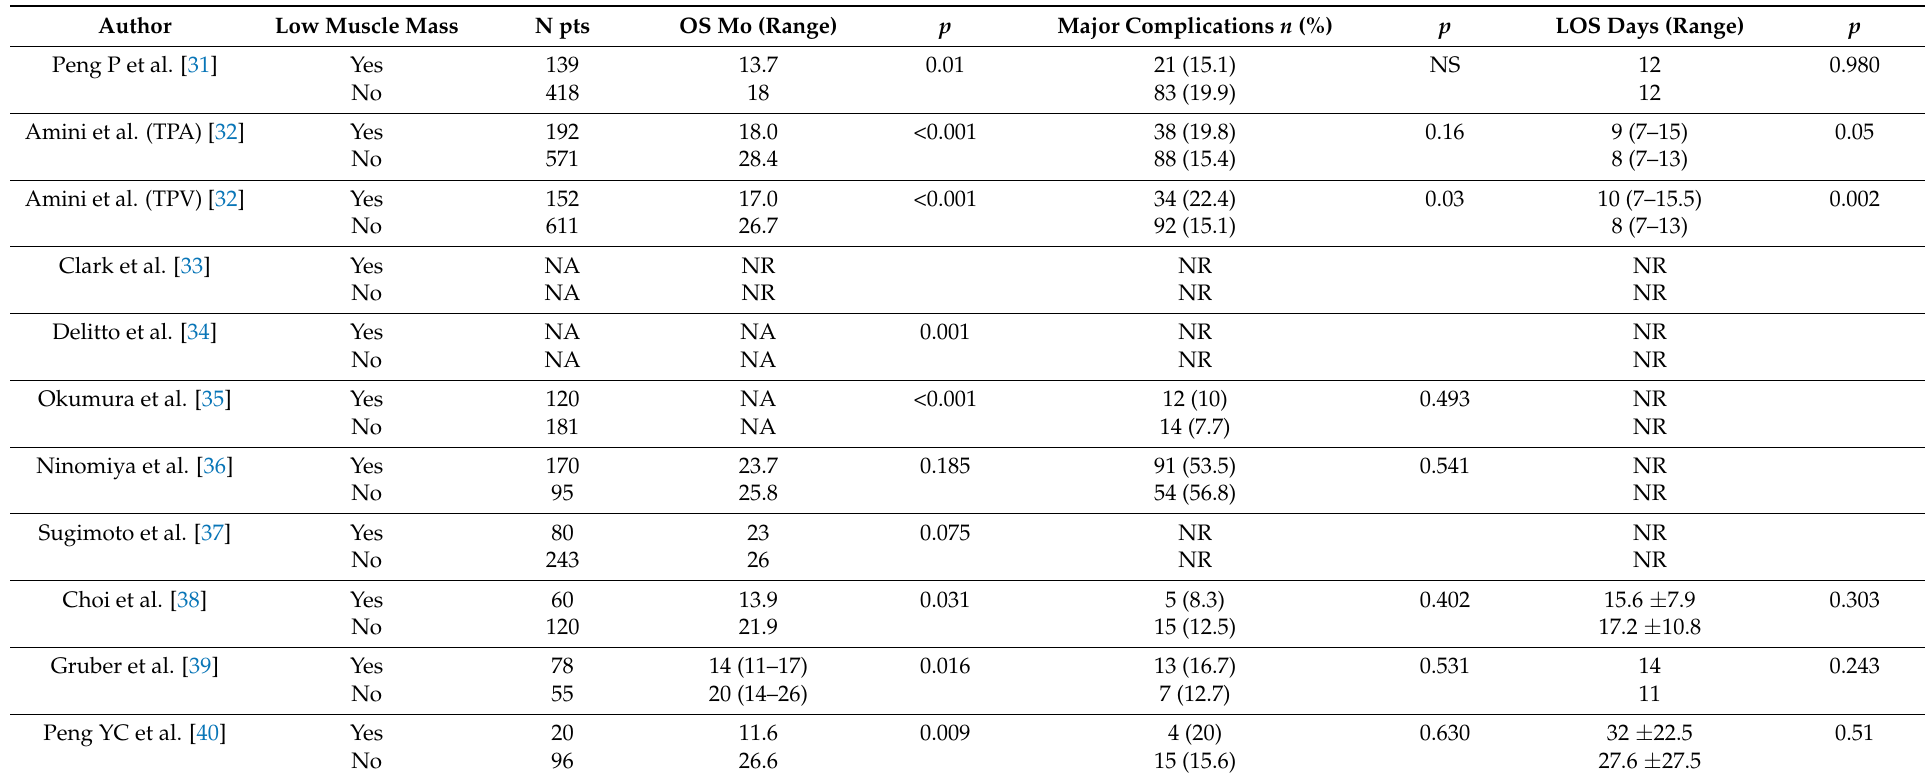
Table 3. Studies included in the quantitative analyses and outcomes used for the three